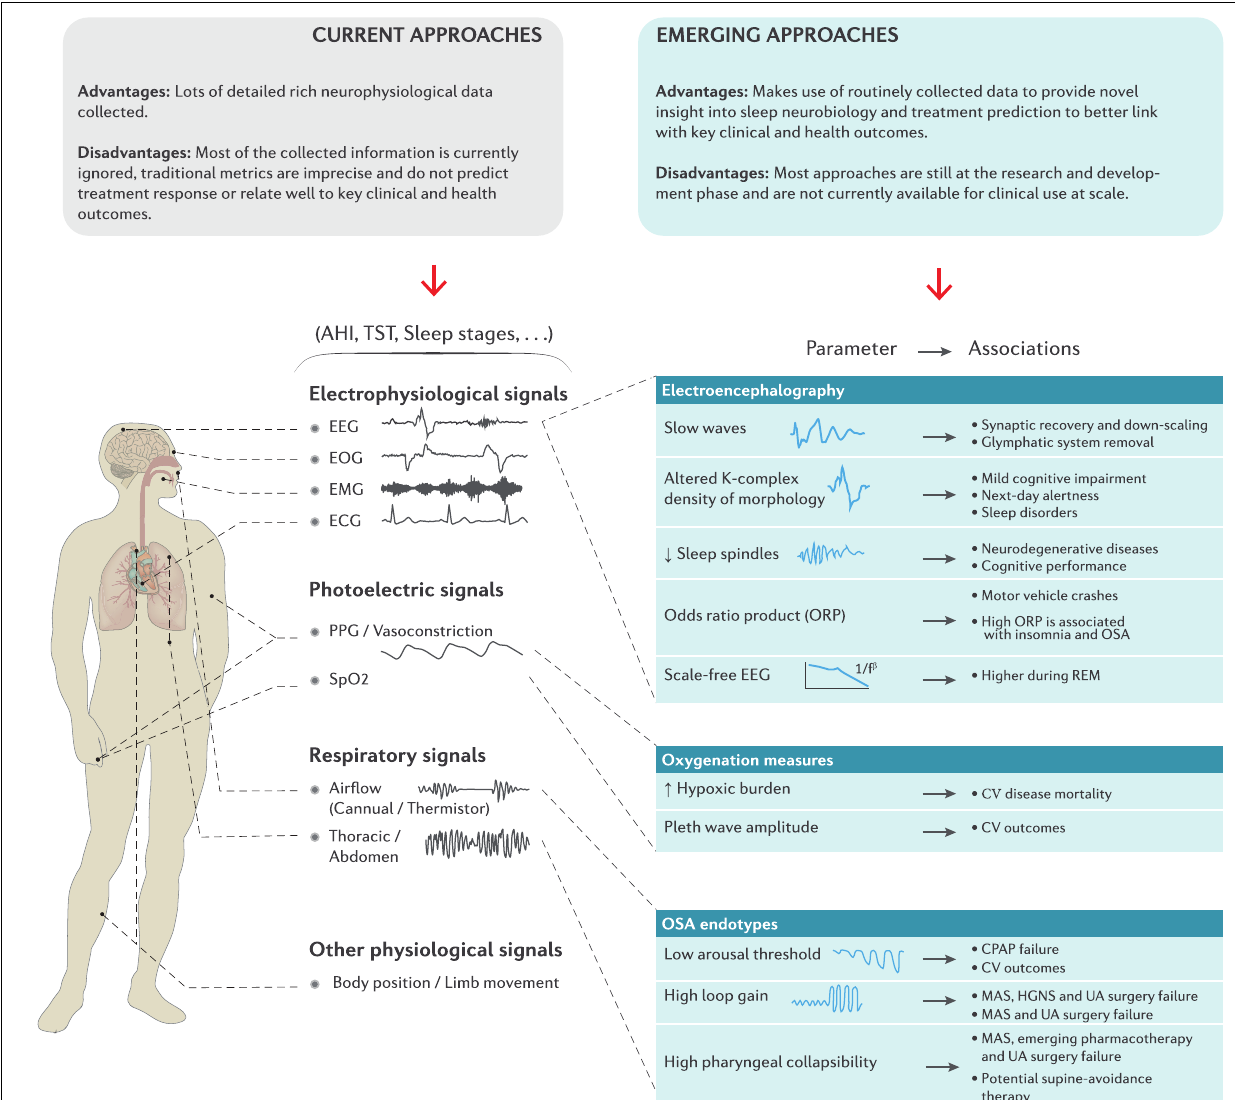
FIGURE 2 | Schematic overview of the current metrics derived from standard polysomnography and the potential to make better use of these extensive neurophysiological signals provide novel insight into sleep neurobiology, treatment prediction and to better link with key clinical and health outcomes. Refer to the text for further detail. CPAP = continuous positive airway pressure, CV = cardiovascular, EEG = electroencephalography, EMG = electromyography, EOG = electrooculography, ECG = electrocardiography, HGNS = hypoglossal nerve stimulation, MAS = mandibular advancement splint, PPG = Photoplethysmography, REM = rapid eye movement, SpO 2 = estimated arterial blood oxygen saturation and UA = upper airway.